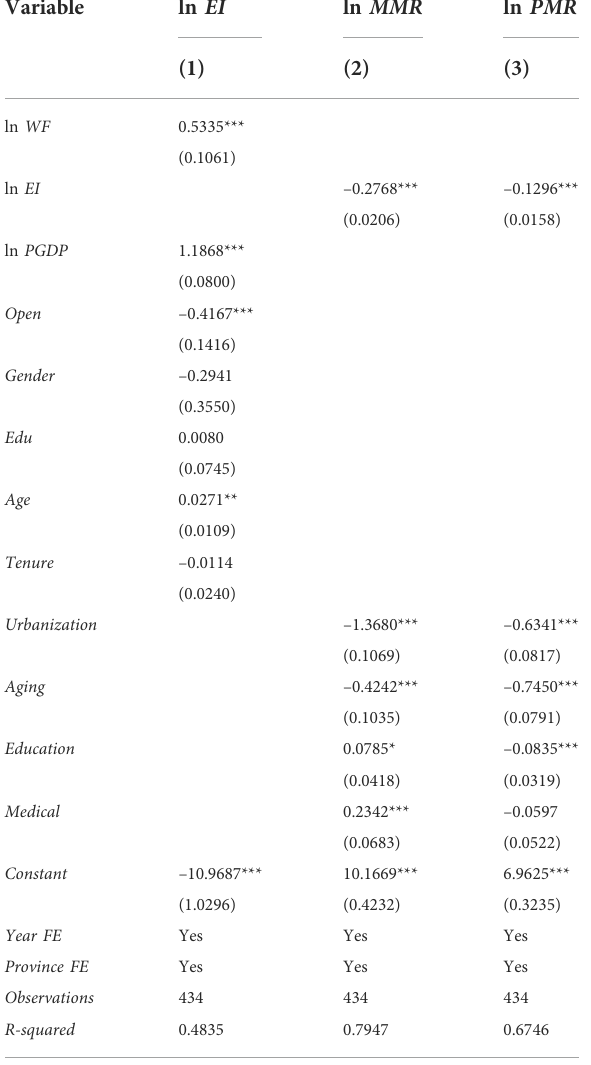
TABLE 3 Results for mediation